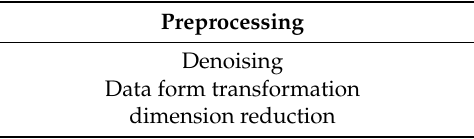
Table 3. Combination